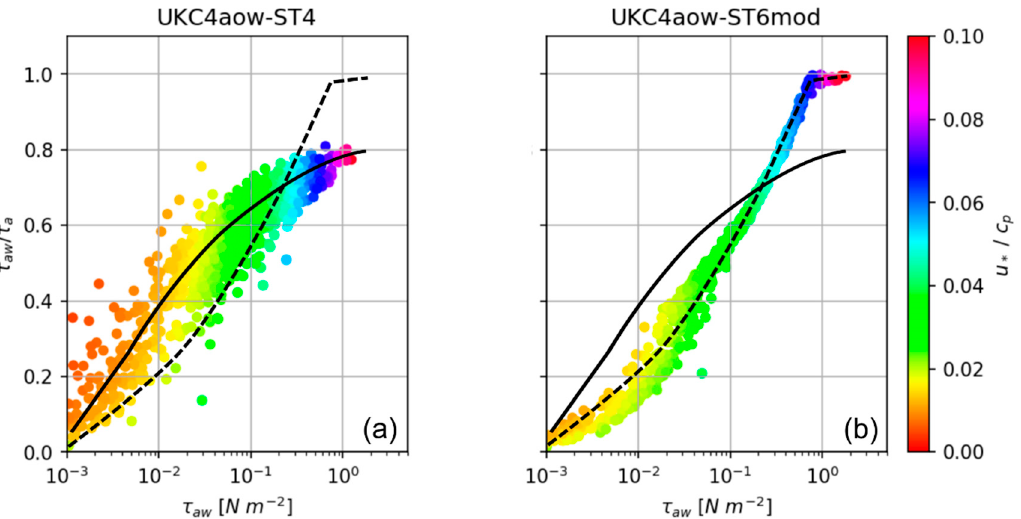
Figure 12. Ratio of momentum atmosphere-wave τ aw / τ a versus wave supported stress τ aw . τ aw − τ aw / τ a relationships are established for ( a ) UKC4aow–ST4 (solid line) and ( b ) UKC4aow–ST6mod (dashed line). Magnitude of inverse wave age u ∗ / c p is included. Wave age is defined as the ratio of a characteristic wind friction velocity to the surface wave phase speed at the peak of the wave spectrum ( u ∗ / c p ) as per Sullivan et al.